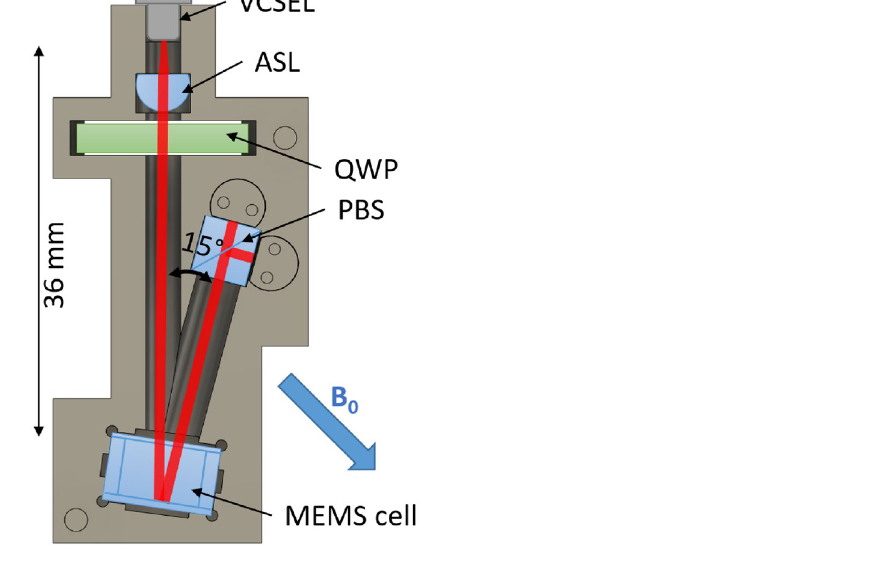
Figure 1. Schematic showing the sensor package, including vertical cavity surface-emitting laser (VCSEL), aspheric lens (ASL), quarter-wave plate (QWP), polarising beam splitter (PBS) and micro-fabricated caesium vapour cell (MEMS cell). The distance between the VCSEL and the caesium cell (36 mm) and the opening angle for the reflected light (15 degrees) are indicated. The static magnetic field is offset from the incident light propagation direction by 45 degrees and the magnetic modulation field (not shown) is applied perpendicular to the plane of light